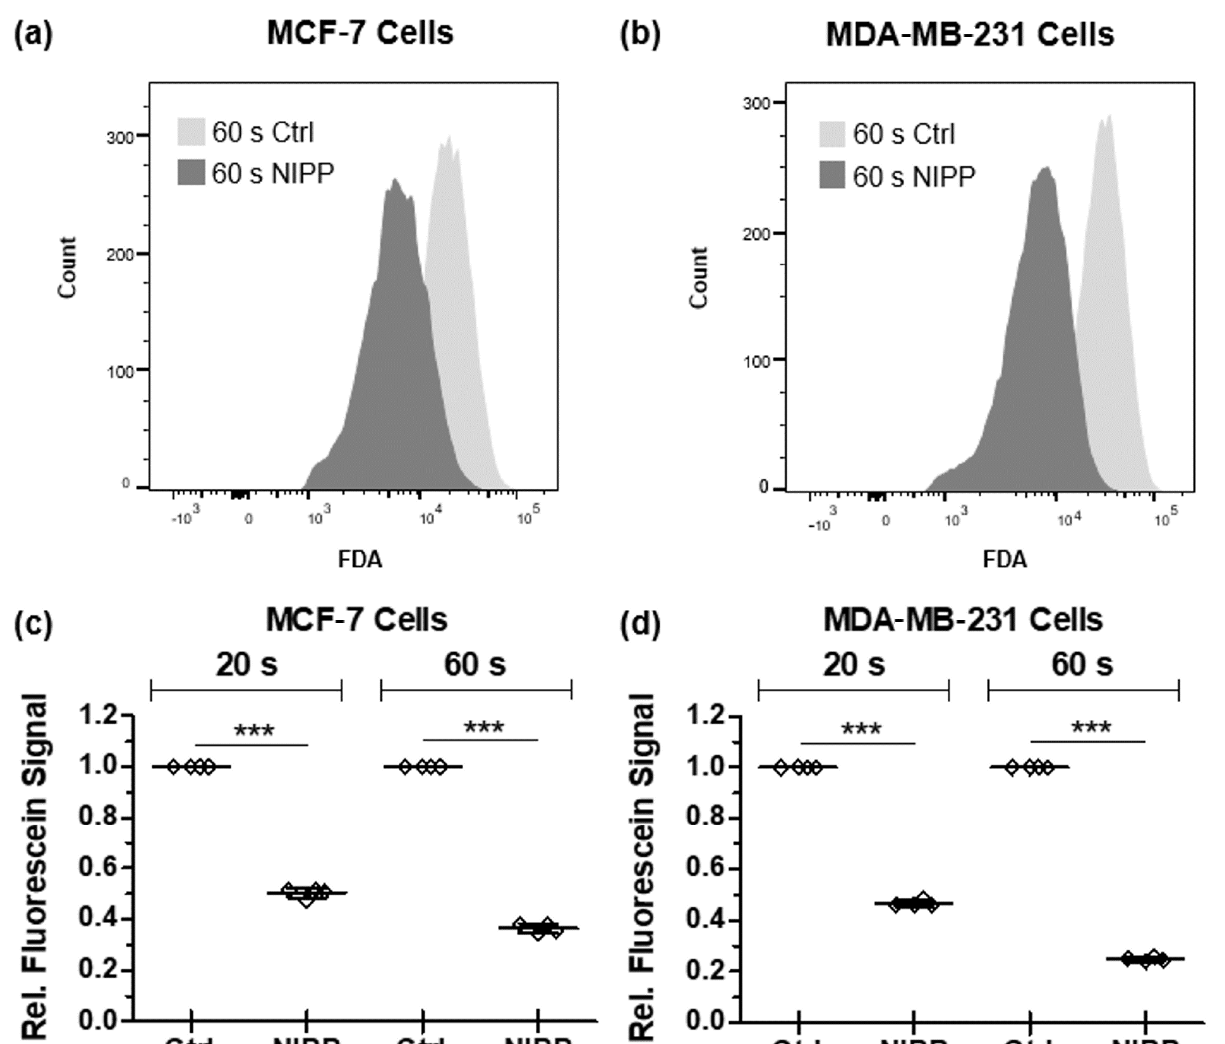
Figure 5. Fluorescein release assay. Breast cancer cells MCF-7 ( a , c ) and MDA-MB-231 ( b , d ) were treated with NIPP for 20 and 60 s, and loaded with membrane-permeable fluorescein diacetate (FDA). ( a , b ) Flow cytometric raw data of 60 s of NIPP treatment. Control cells were treated with argon for appropriate times (Ctrl). The enzymatic conversion of FDA to non-membrane permeable fluorescein prevents the release of the dye under physiological conditions. Fluorescein release was determined by flow cytometry (BD FACSCanto™ flow cytometer and FlowJo software version 10) and expressed as relative signal normalized to controls. The results are displayed as mean ± standard deviation ( p ≤ 0.001 ***).